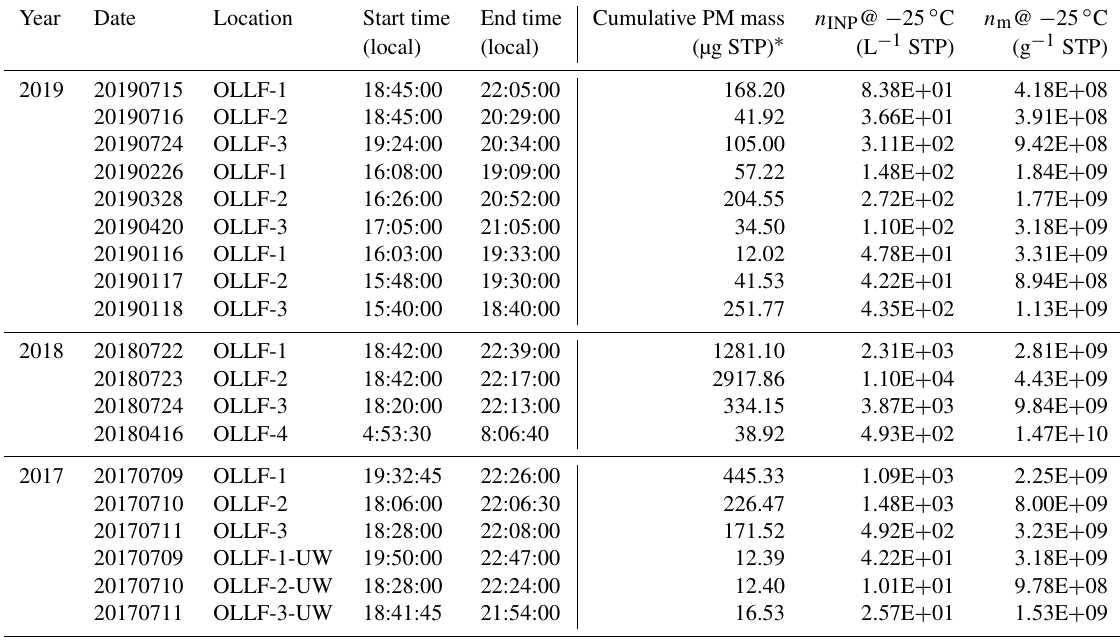
Table 6. Summary of the ambient aerosol particle mass and immersion freezing properties of all field samples used in this study: UW denotes